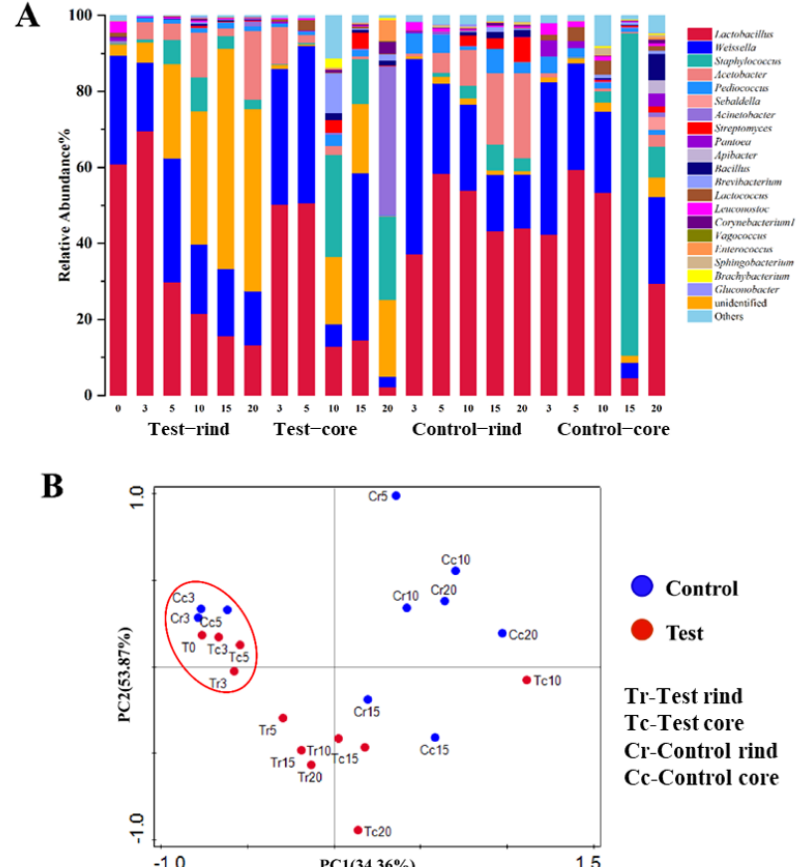
Figure 4. ( A ) The relative abundance of the dominant bacterial communities in Daqu at the genus level. ( B ) Principal component analysis of the bacterial communities based on weighted UniFrac distances. The red circle represents clustered results. Tr represents the rind of the test group; Tc represents the core of test group; Cr represents the rind of the control group; Cc represents the core of the control group.